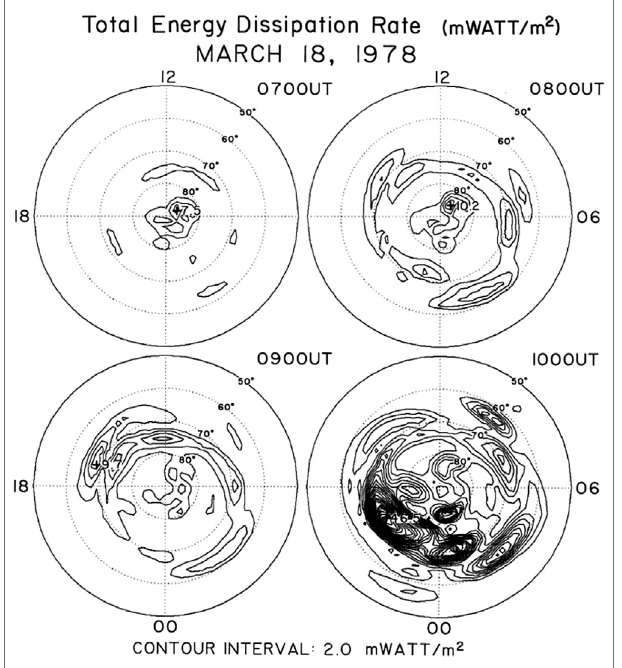
FIGURE17| ThedevelopmentoftheJouleheatdissipationrateduringa substorm (Ahn et al., 1983). about one hour behind the DD current. This delay period is called the growth phase.